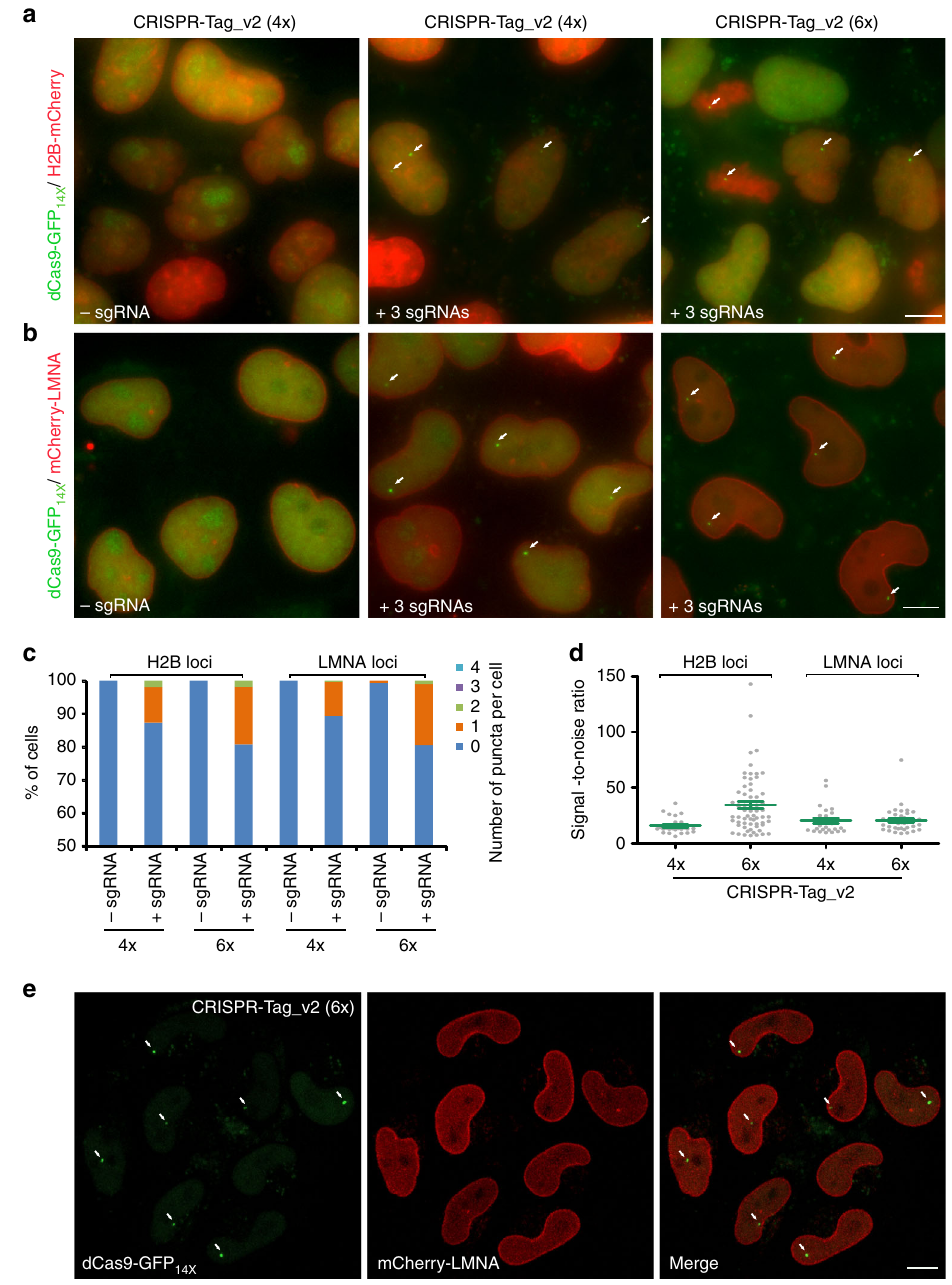
Fig. 3 CRISPR-Tag in intron enables simultaneous visualization of DNA and protein of endogenous genes. a Visualization of H2B locus using CRISPR- Tag_v2 (containing four or six repeat units), which was inserted into the intron of mCherry. H2B-mCherry was imaged and H2B loci were labeled by dCas9- GFP 14X with three sgRNAs (sgTS5 – sgTS7). b Visualization of LMNA locus using CRISPR-Tag_v2 with three sgRNAs (sgTS5 – sgTS7). c Labeling ef fi ciency of H2B and LMNA loci shown in a and b , respectively, was determined by counting the number of spots in each cell, n ≥ 191 cells. d Labeling ef fi ciency of H2B and LMNA loci was determined by quantifying signal-to-noise ratio, n ≥ 25 cells. Green line denotes means ± SEM. e Confocal images of mCherry-LMNA and LMNA loci labeled by dCas9-GFP 14X and CRISPR-Tag_v2 (6x). All images in a , b , and e are maximum intensity projections from z stacks. Scale bars: 10 µ